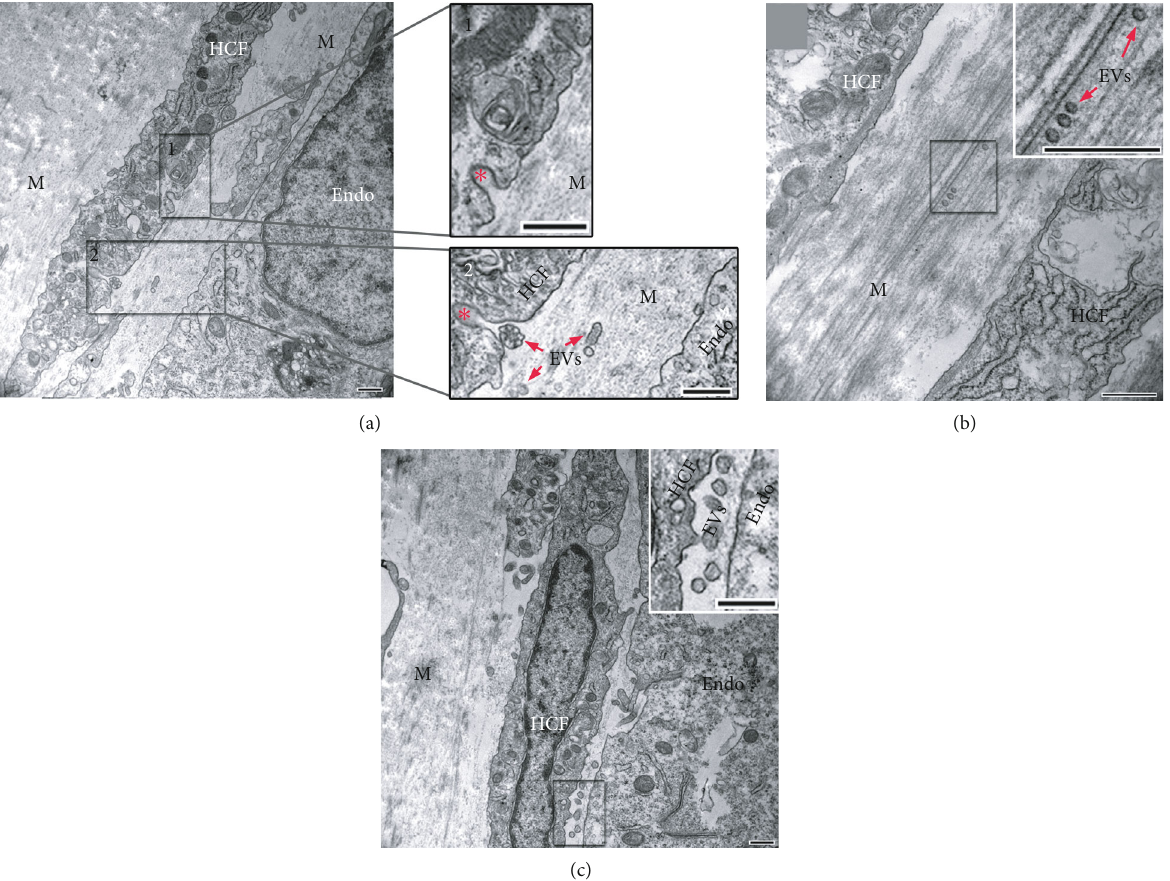
Figure 3: EVs distributed in a 3D tissue-engineered corneal endothelial-stromal model. (a) A coculture of human corneal fi broblast (HCF) and human corneal endothelial cells (Endo) shows (1) endocytosis/exocytosis ( red asterisks ) and (2) EVs ( red arrows ) present in the matrix (M) and a cluster of EV endocytosing/exocytosing. (b) EVs distributed within the stromal matrix. (c) EVs present between an HCF and Endo cell. Bars = 500 nm . Images were modi fi ed and reproduced from Zieske et al. (2020) [56] based on a Creative Commons BY license (CC BY 4.0),